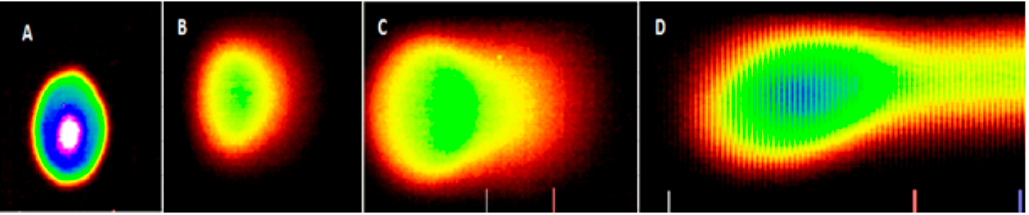
Figure 5. Representative SYBR Green comet assay images of untreated control ( A ) and Vernonia amygdalina Delile (VAD)-treated PC-3 cells at 125 µg/mL ( B ); 250 µg/mL ( C ); and 500 µg/mL ( D ). Cells observed in the treated images for each VAD dose exhibited an increase in DNA damage as VAD dose rose.